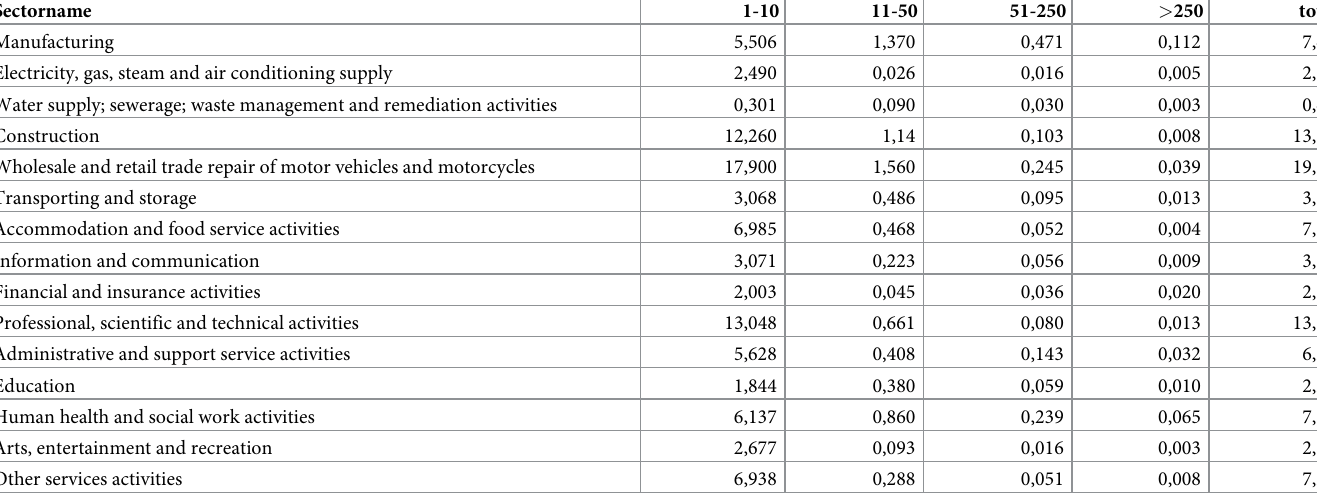
Table 2. Percentages of companies in different size classes and economic sectors in the eight federal states.